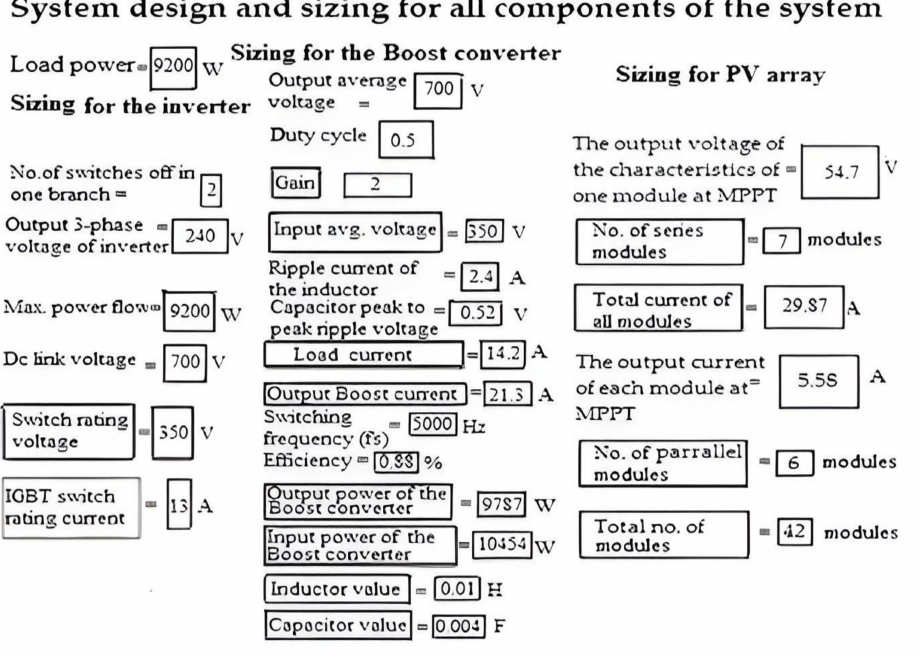
Figure 12. Three-phase grid and inverter current for fuzzy-PI controller of low load. For example, load power = 9200